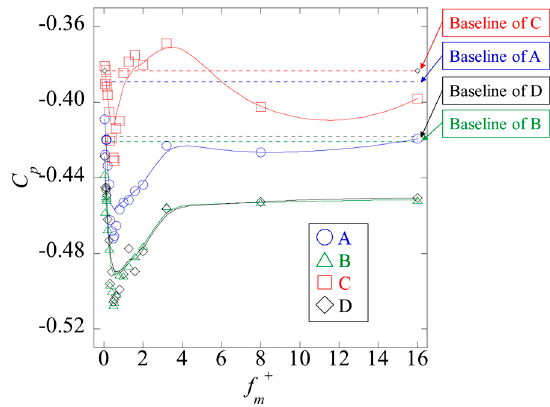
Figure 17. C p as a function of f m + . Symbols A, B, C, and D indicate measured positions on the model surface shown in Figure 5.